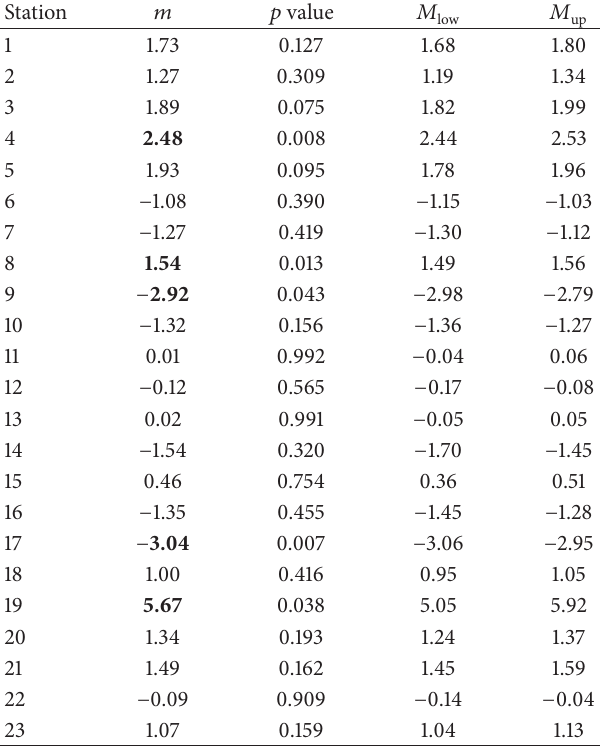
Table 4: Uncertainty in trend slopes due to noise in the